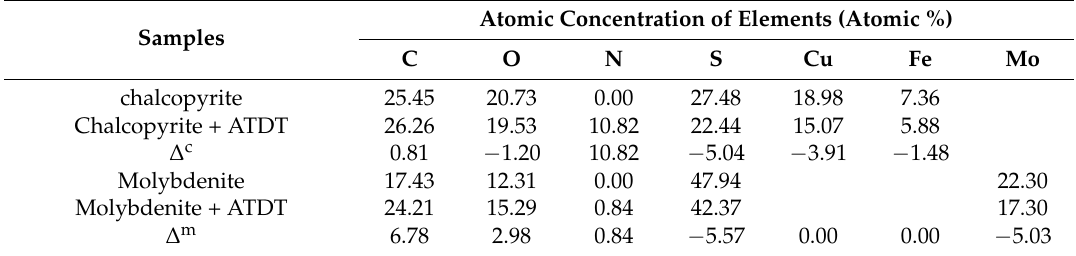
Table 3. Elements atomic contents of samples before and after